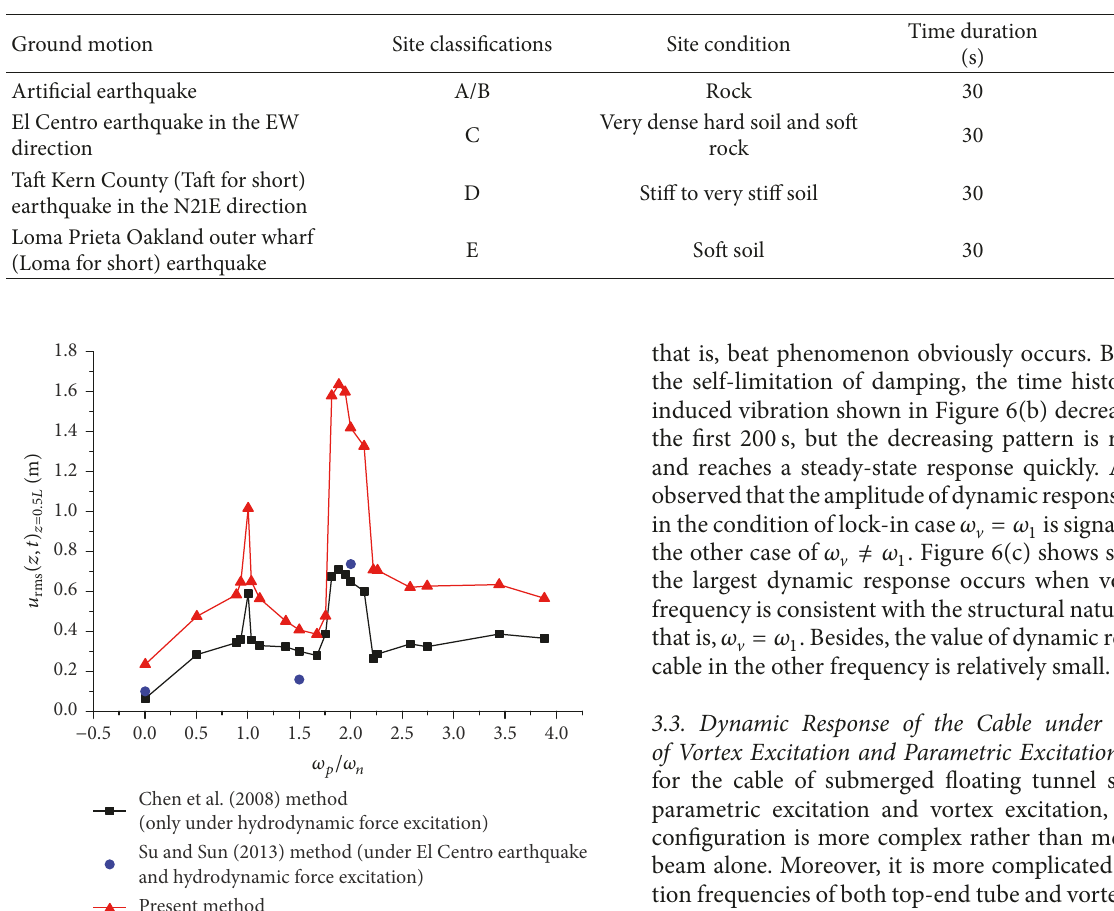
Figure 5: Variations of RMS of mid-span displacement of the cable with 𝜔 𝑝 /𝜔 𝑛 calculated using different